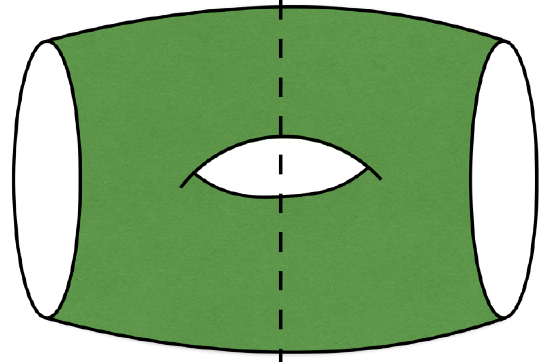
Figure 1 . The surface T used to de(cid:12)ne the torus operator T . The surface has three Z 2 symmetries, acting on the page by re(cid:13)ecting front-to-back, right-to-left across the vertical dashed line, and top- to-bottom. Cutting the path integral along the plane de(cid:12)ned by the normal to the page and the vertical axis (dashed line) decomposes T into the product A y A where A maps our CFT Hilbert space H to H (cid:10) H